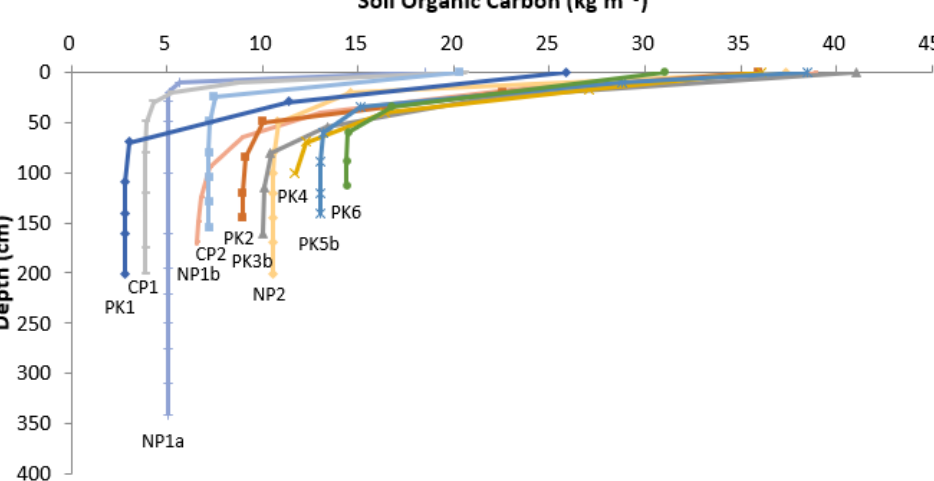
Figure 3. Pakua tableland SOC negative exponential function value variation with depth.